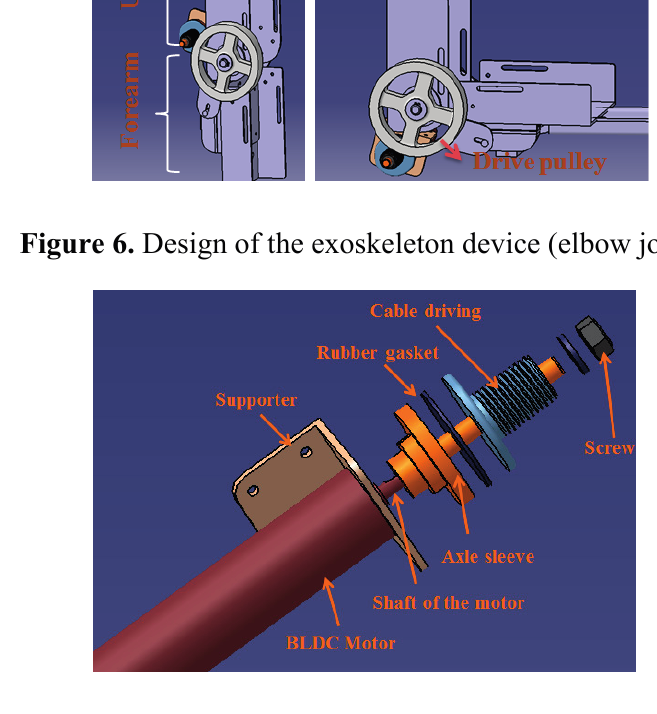
Figure 7. Torque-limiter mechanism in the elbow